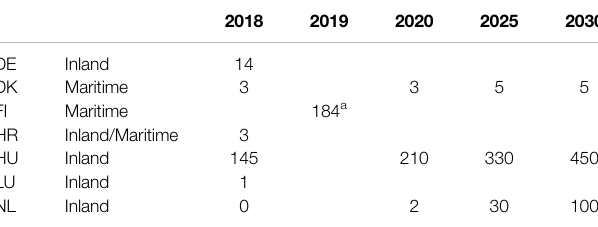
TABLE 1 | Electric vessels indicated in the